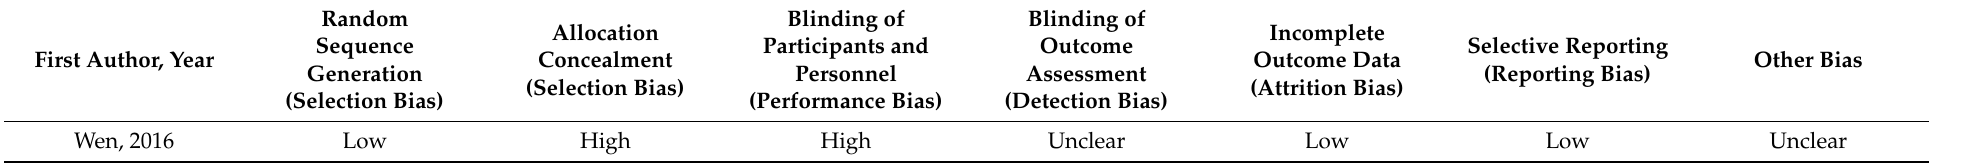
Table A5. Risk of bias in included studies. Table A6. Newcastle–Ottawa Scale quality assessment scale for cohort studies.